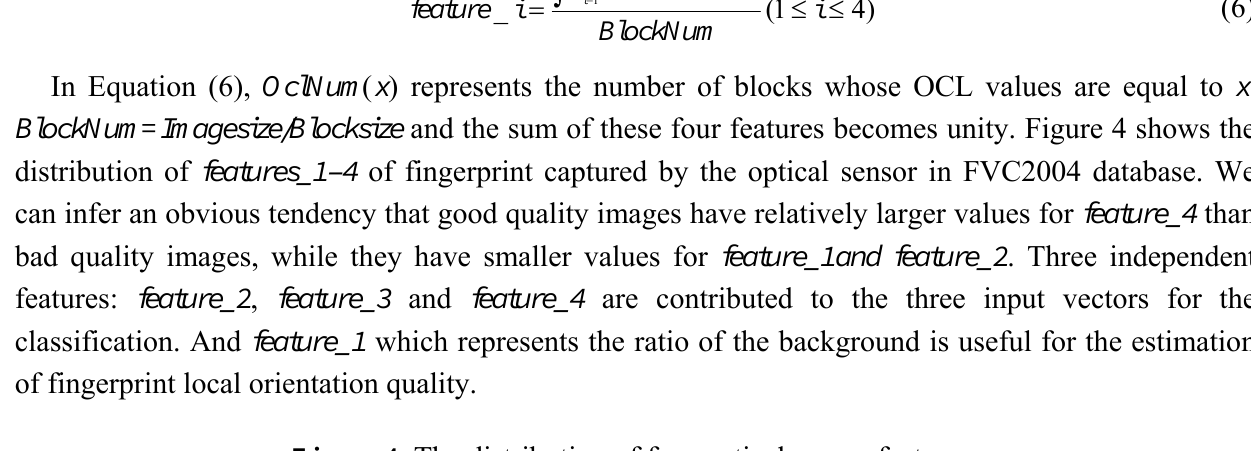
Figure 4. The distribution of four optical sensor